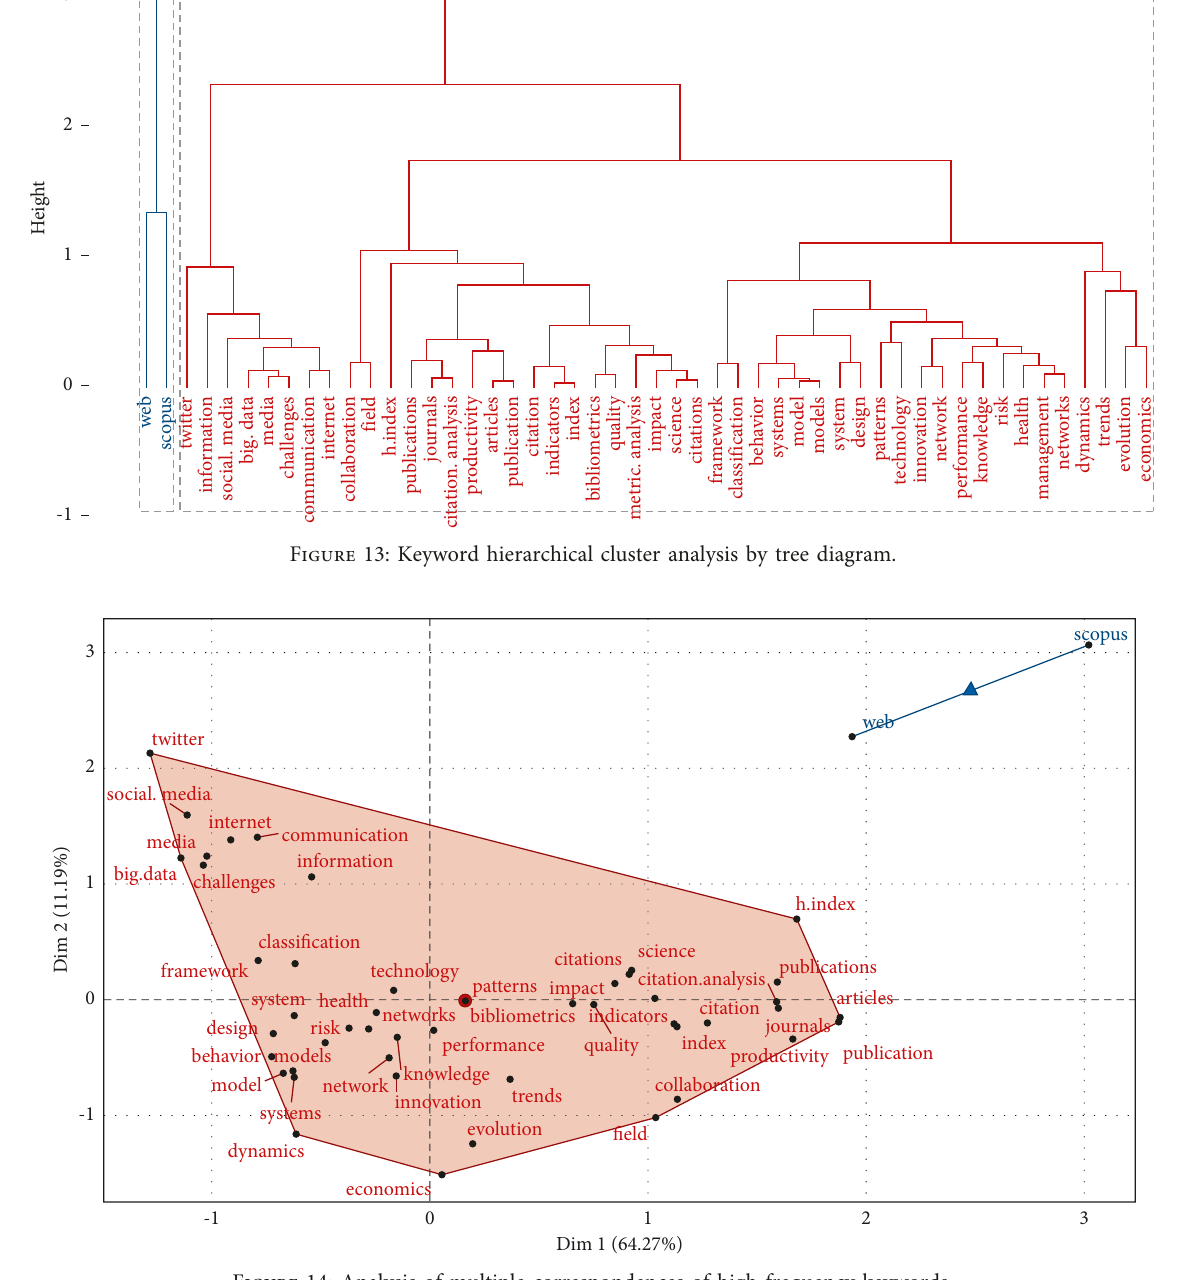
Figure 14: Analysis of multiple correspondences of high-frequency keywords.